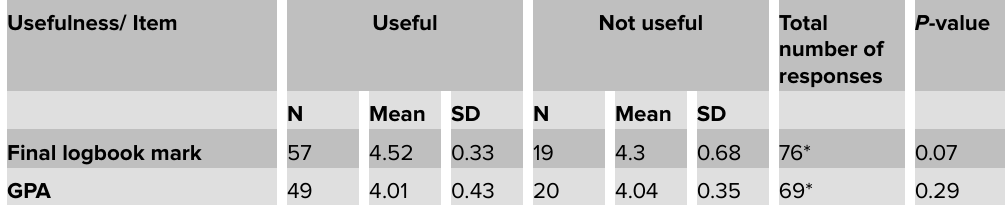
TABLE 4: Correlation between students’ perceptions of usefulness of logbook to their learning and their final logbook mark and GPA ( N =